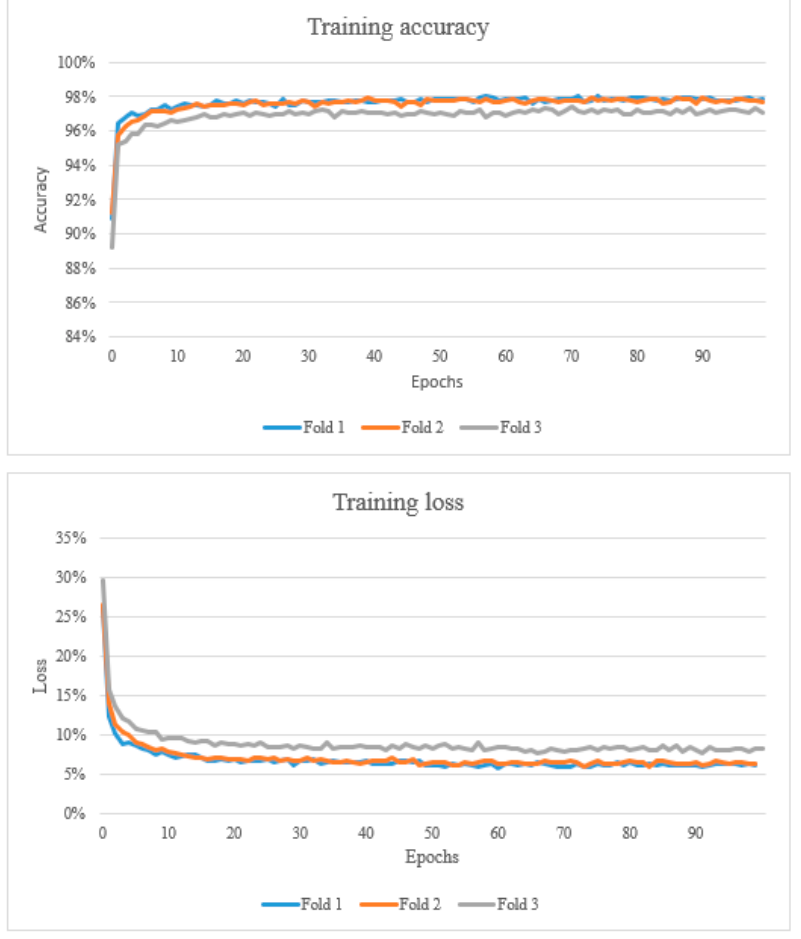
Figure 2. The top graph shows the training accuracy (learning curve). A learning curve is a plot that shows epochs on the x-axis and learning or improvement on the y-axis. The bottom graph shows the training loss which represents the summation of errors in the